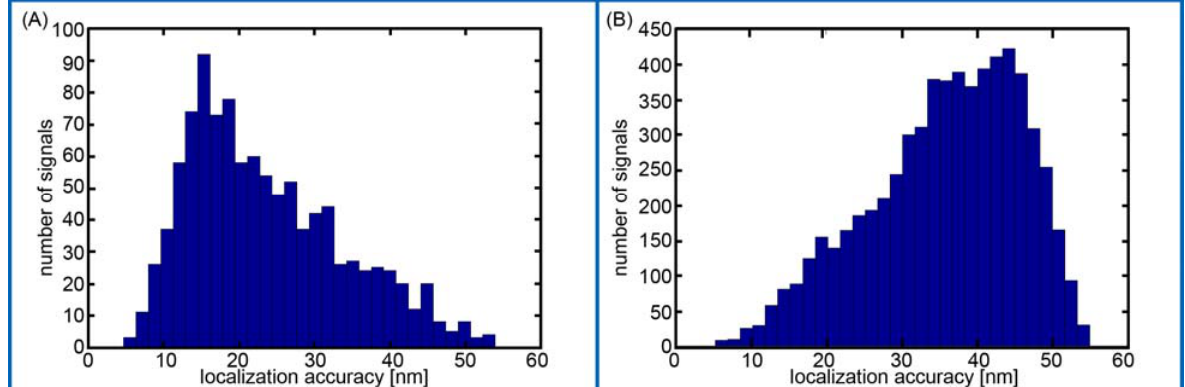
Figure 4. Frequency histograms of the localization accuracy of signals that have been detected within the ( A ) centromere clusters and ( B ) background region of the cell nucleus in Figure